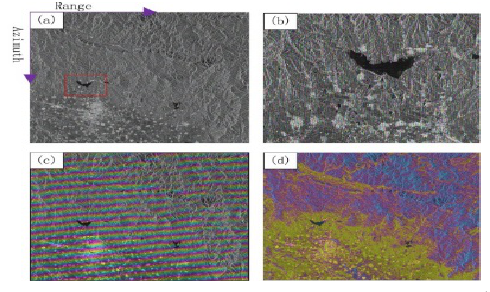
Figure 4. Interferometric processing results of Tangshan. (a) is the interferogram map; (b) is a local large map of the red rectangular box in figure (a); (c) is the flattened interferogram map; (d) is the coherence map.